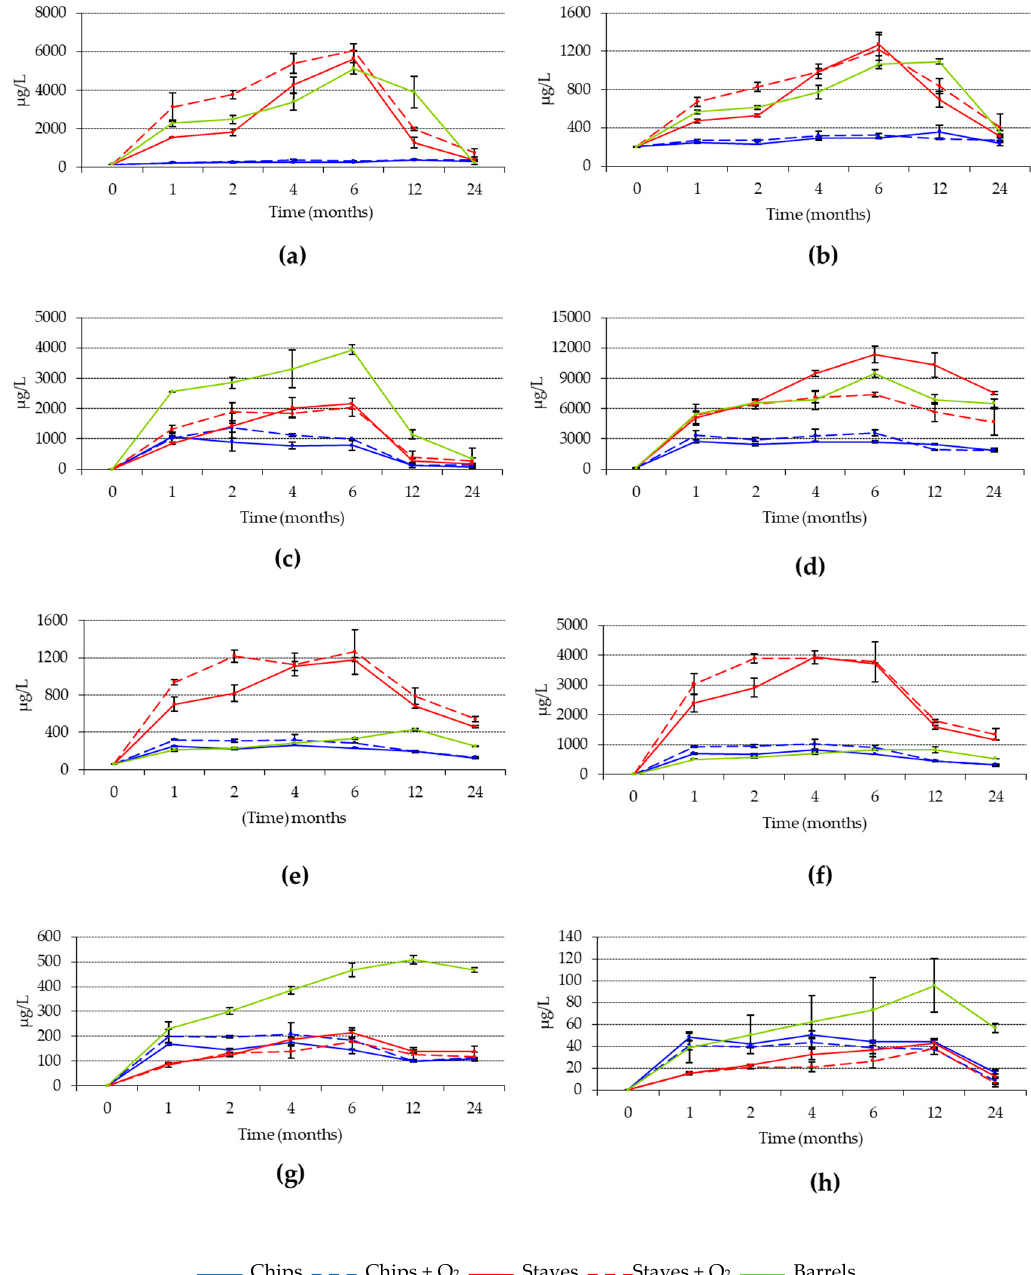
Figure 3. Evolution over time of furanic compound concentration ( µ g/L): ( a ) furfural, ( b ) 5-methylfurfural, ( c ) 5-hydroxymethylfurfural, and ( d ) furfuryl alcohol; of benzoic aldehyde concentration ( µ g/L): ( e ) vanillin, and ( f ) syringaldehyde; and of oak lactone concentration ( µ g/L): ( g ) cis - β -methyl- γ -octalactone, and ( h ) trans - β -methyl- γ -octalactone. Mean ± standard deviation ( n = 2).